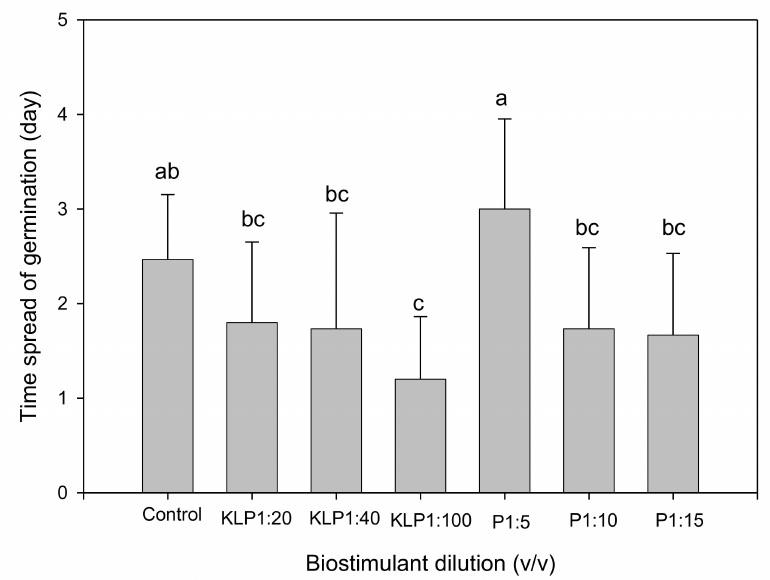
Figure 3. Effect of seed priming with biostimulants (KLP, Kelpak ® ; P, plant-growth-promoting rhizobacteria) on time spread of Abelmoschus esculentus seed germination. Bars representing mean values and standard errors with different letters indicate statistically significant ( p ≤ 0.05) differences based on Fisher’s protected least significant difference test (Genstat 64-bit Release